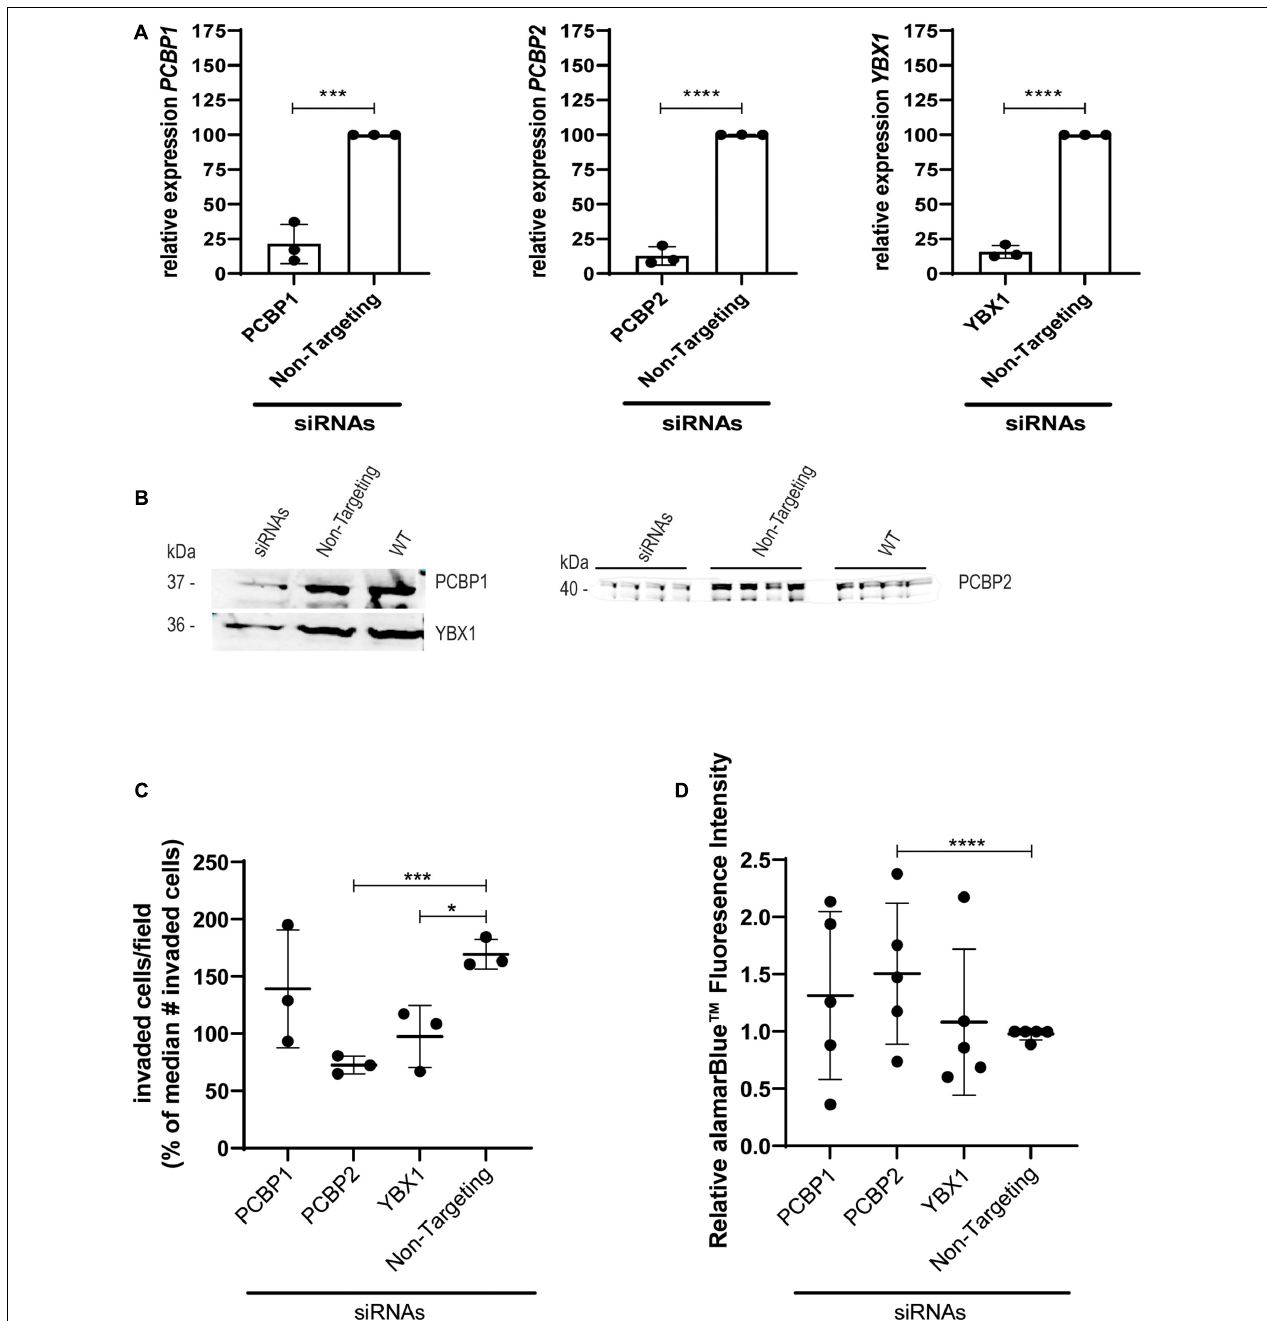
FIGURE 1 | Upon knockdown of YBX1, PCBP1, and PCBP2 EVT-like cells fail to differentiate toward an invasive phenotype. (A) qPCR results demonstrating successful mRNA downregulation of PCBP1 , PCBP2, and YBX1 in HTR-8/SVneo cells after transfection with respective siRNAs. An siRNA not targeting any known mammalian gene was used as a control. Normalization was done using the geometric mean of reference genes PSMD4 and YWHAZ . Experiments were repeated 3 times using 3 replicates per treatment. (B) Successful siRNA-induced downregulation of target genes on protein level as shown by Western blot. Equal protein loading control was performed by total protein Revert stain ( Supplementary Figure 1 ). (C) Transwell invasion assays show that PCBP2 and YBX1 downregulation leads to a significant decrease in invasive behavior of EVT-like cells. Experiments were repeated 3 times using 6 replicates per treatment. (D) Quantification of proliferation using alamarBlue TM solution. The proliferation rate of EVT-like cells with downregulated expression of PCBP2 was increased. Experiments were repeated five times using nine replicates per treatment. Data are presented as mean ± SD and tested with two-way ANOVA followed by Dunnett’s multiple comparisons test or with a Student’s t -test in case of two data sets. *Indicates p < 0.05; *** indicates p < 0.001; **** indicates p < 0.0001.